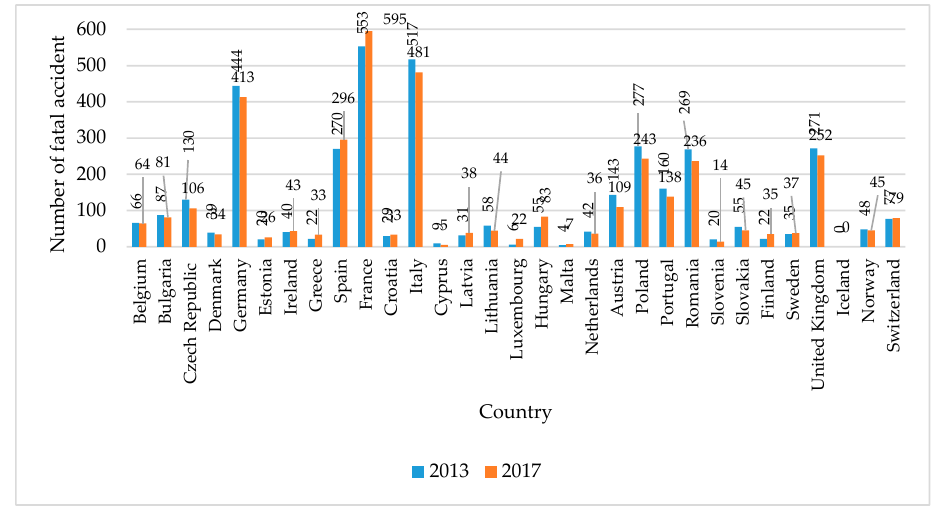
Figure 3. Distribution of fatal accidents for EU member states during 2013–2017 [1].